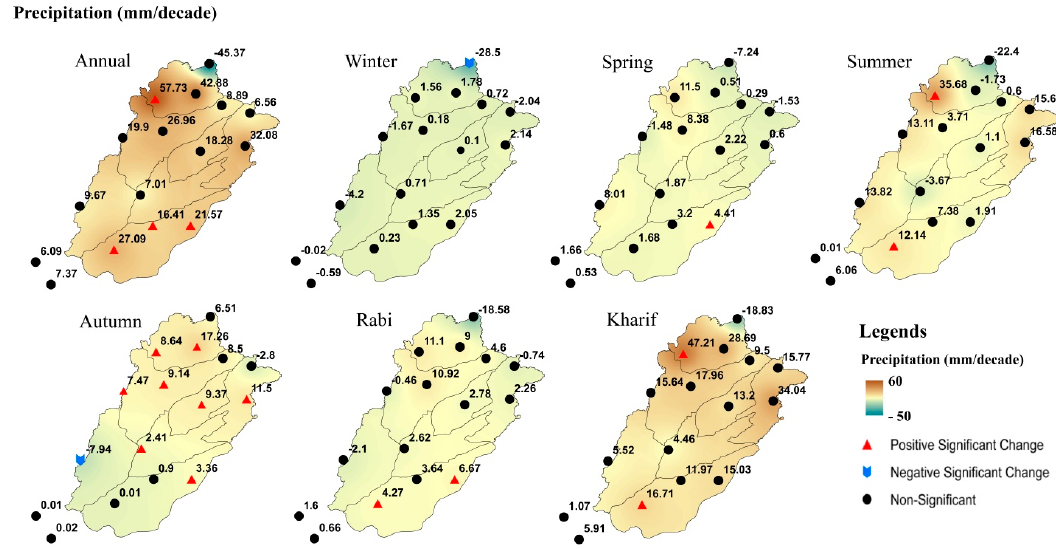
Figure 8. Change per decade and trends of precipitation at meteorological stations (mm) for the entire year, winter, spring, summer, autumn, Rabi, and Kharif in Punjab for the period 1967–2017.